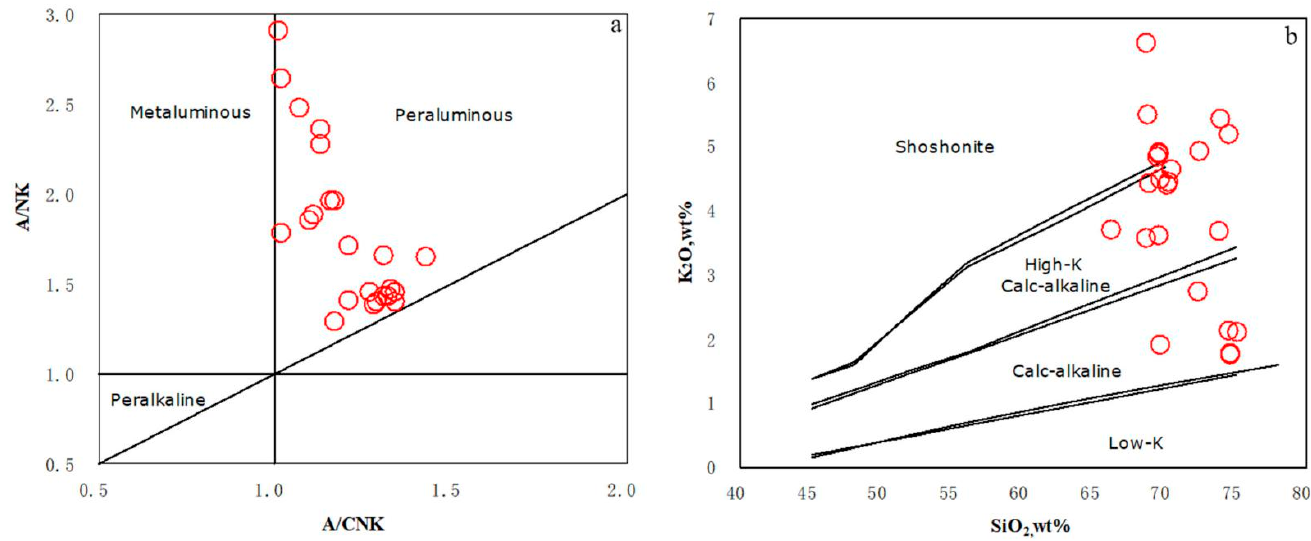
Figure 3. ( a ) A/NK vs. A/CNK (according to Maniar, et al. [14]) and ( b ) K 2 O wt.% vs. SiO 2 wt.% plots for the Dahongliutan pluton (according to Peccerillo, et al. [15]).